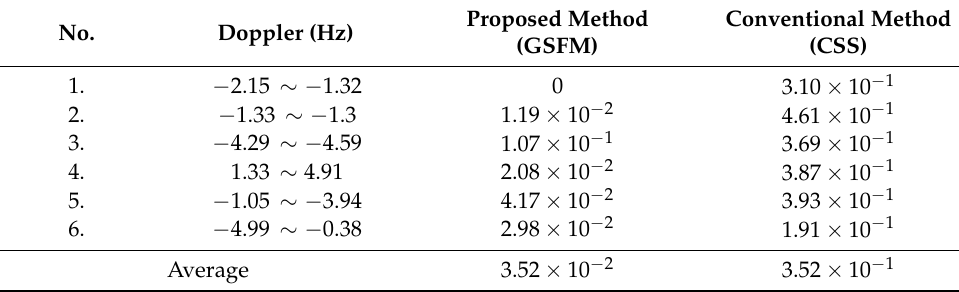
Table 3. Uncoded BER in the lake trial.